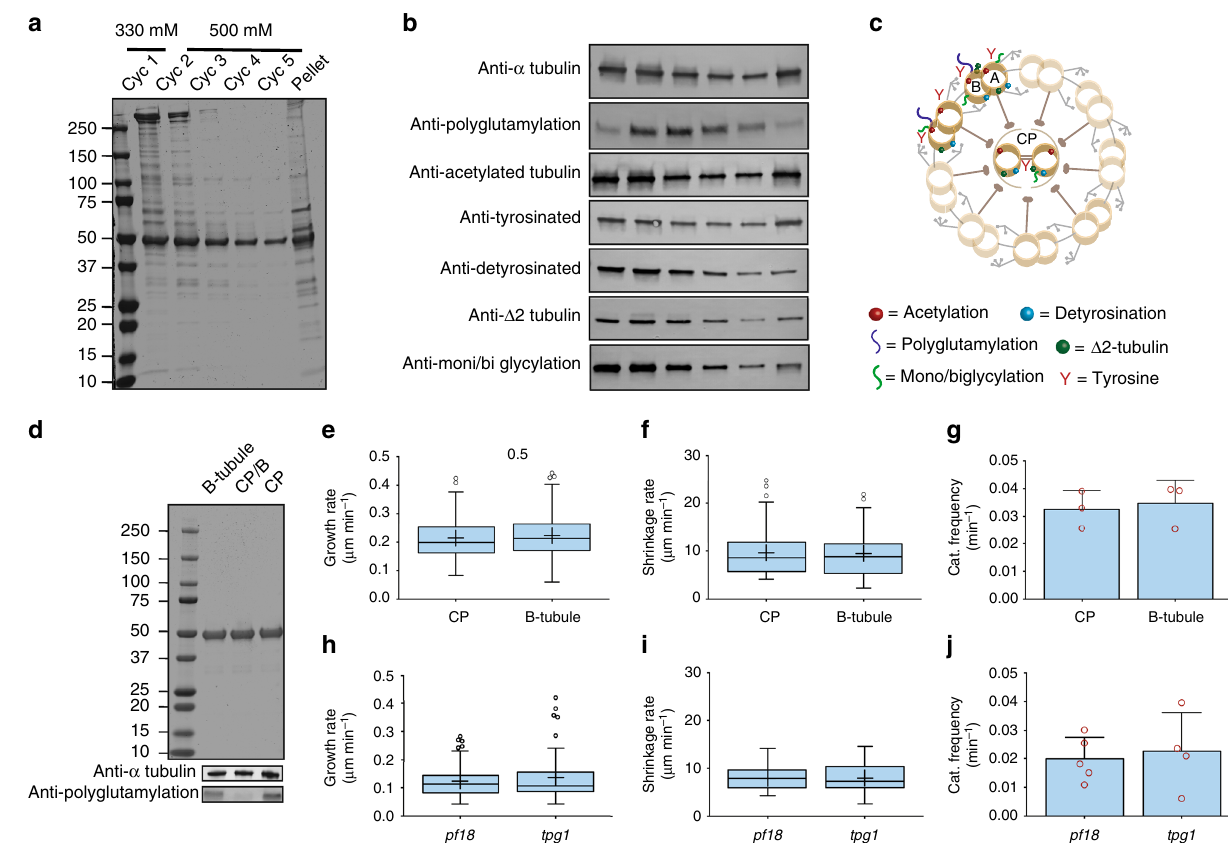
Fig. 3 Puri fi cation, post-translational modi fi cations analysis and dynamics. a SDS-PAGE of samples extracted from the axoneme with lower NaNO 3 concentration in the fi rst cycle only. b Immunoblots of samples from the salt-extraction cycles. c Schematic of the different PTMs on the axoneme structure. d SDS-PAGE and immunoblot of axonemal tubulin puri fi ed from the CP, B-tubule and combined fractions (CP/B). e Tukey plots showing growth rate (127, 146 MTs) and f shrinkage rate of tubulin from the CP and B-tubule (52, 50 MTs) at 9 μ M tubulin concentration. Middle line represents the median, plus sign indicates the mean. g Average catastrophe frequency of axonemal MTs polymerized from CP and B-tubule at 9 μ M tubulin concentration. Error bars are SD for n = 3 independent experiments. h Tukey plots showing growth rate (82, 201 MTs) and i shrinkage rate of tubulin from the pf18 and tpg1 at 9 μ M tubulin concentration (24, 25 MTs). Middle line represents the median, plus sign indicates the mean. j Average catastrophe frequency of axonemal MTs polymerized from pf18 and tpg1 , derived from three independent experiments. Error bars are SD for n = 5, 4 independent experiments. Source data are provided as a Source Data fi